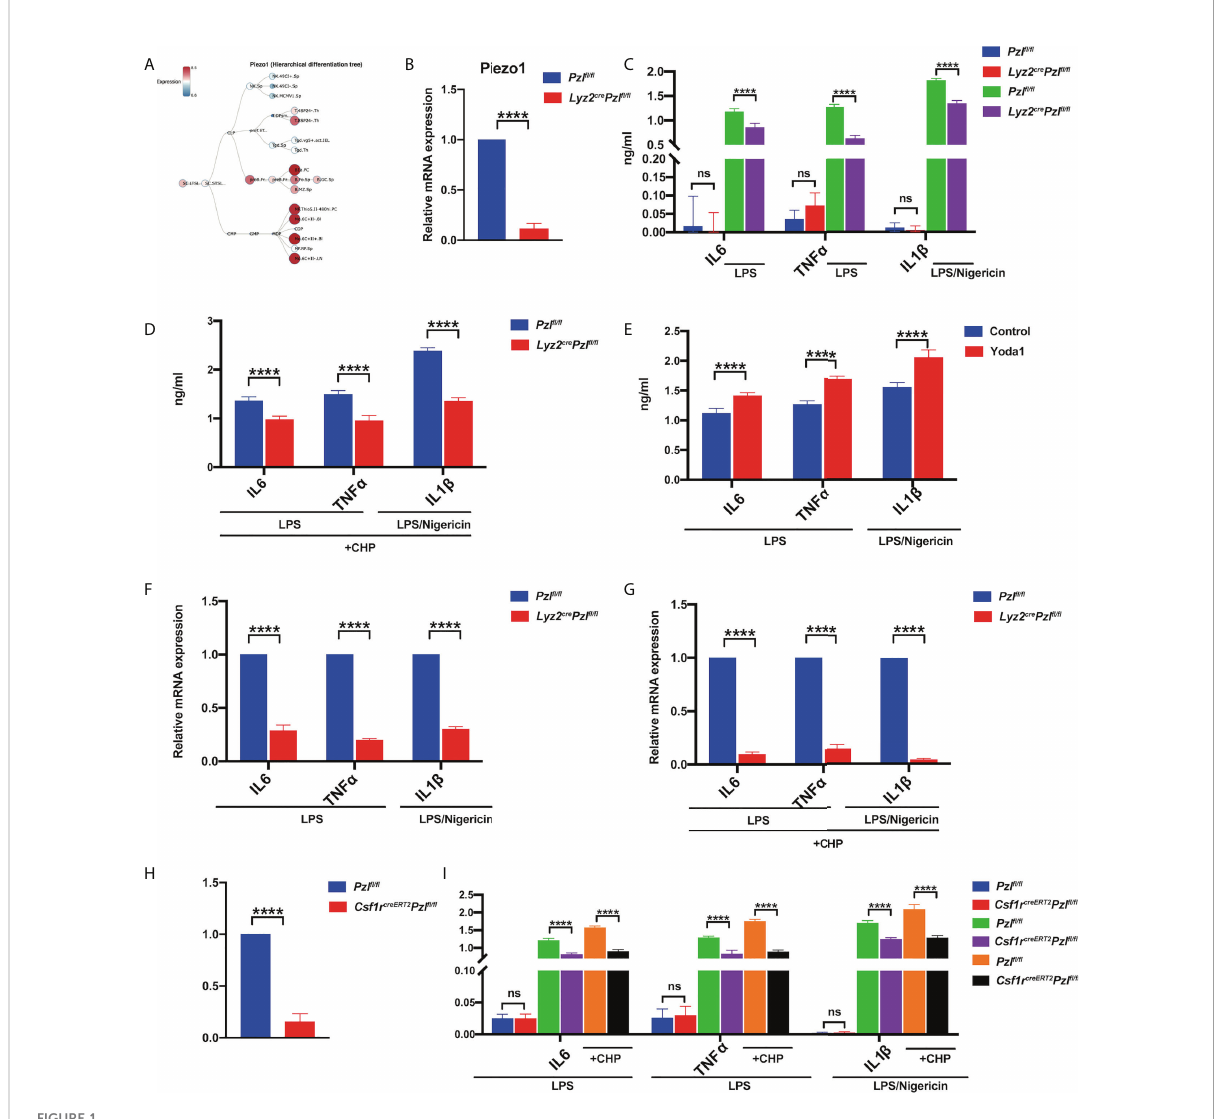
FIGURE 1 Piezo1 activation promotes LPS-induced expression and secretion of in fl ammatory cytokines. (A) A hierarchical differentiation tree depicting the expression of Piezo1 using BloodSpot (online software). (B) The expression of Piezo1 mRNA in the BMDMs from Lyz2 cre/+ Piezo1 fl ox/ fl ox and Piezo1 fl ox/ fl ox control mice relative to b -actin (n = 6). (C) IL6 and TNF- a levels in the BMDMs from Lyz2 cre/+ Piezo1 fl ox/ fl ox mice and Piezo1 fl ox/ fl ox control mice treated with 10 ng/ml LPS for 24 h; IL-1 b level in the BMDMs from Lyz2 cre/+ Piezo1 fl ox/ fl ox mice and Piezo1 fl ox/ fl ox control mice treated with 1 µg/ml LPS for 4 h and 25 µM nigericin for 30 min, measured by ELISA (n = 6). (D) IL6 and TNF- a levels in the BMDMs from Lyz2 cre/+ Piezo1 fl ox/ fl ox mice and Piezo1 fl ox/ fl ox control mice treated with 10 ng/ml LPS under cyclical hydrostatic pressure cycling once per second from 45 mmHg to 60 mmHg with 5% CO 2 at 37°C for 6 h; IL-1 b level in the BMDMs from Lyz2 cre/+ Piezo1 fl ox/ fl ox mice and Piezo1 fl ox/ fl ox control mice treated with 1 µg/ml LPS for 4 h and 25 µM nigericin for 30 min, measured by ELISA under CHP (n = 6). (E) IL6 and TNF- a levels in the BMDMs with 10 ng/ml LPS for 24 h pretreated with 10 µM Yoda1 or DMSO for 30 min; IL-1 b level in the BMDMs with 1 µg/ml LPS for 4 h and 25 µM nigericin for 30 min pretreated with 10 µM Yoda1 or DMSO for 30 min (n = 6). (F) Relative gene expression of IL6, TNF- a , and IL-1 b in the BMDMs from Lyz2 cre/+ Piezo1 fl ox/ fl ox mice and Piezo1 fl ox/ fl ox control mice incubated with 10 ng/ml LPS for 2 h or 1 ug/ml LPS for 4 h and 25 µM nigericin for 30 min (n = 6). (G) Relative gene expression of IL6 and TNF- a in the BMDMs from Lyz2 cre/+ Piezo1 fl ox/ fl ox mice and Piezo1 fl ox/ fl ox control mice treated with 10 ng/ml LPS for 2 h under cyclical hydrostatic pressure; relative gene expression of IL-1 b in the BMDMs treated with 1 ug/ml LPS for 4 h and 25 µM nigericin for 30 min (n = 6). (H) The expression of Piezo1 mRNA in BMDMs from Csf1r creERT2 ; Piezo1 fl ox/ fl ox and Piezo1 fl ox/ fl ox control mice relative to b -actin (n = 6). (I) IL6, TNF- a , and IL-1 b secretion in the BMDMs from Csf1r creERT2 ; Piezo1 fl ox/ fl ox mice and Piezo1 fl ox/ fl ox control mice incubated with 10 ng/ml LPS for 24 h, 1 µg/ml LPS for 4 h, and 25 µM nigericin for 30 min under static pressure or cyclical hydrostatic pressure (n = 6). Statistical signi fi cances were calculated using (C, I) one-way ANOVA, Tukey ’ s multiple comparisons test; (B, D – H) two-tailed Student t test. Data are expressed as the mean ± SD. **** P < 0.0001, ns, not signi fi cant. BMDMs, bone marrow-derived macrophages; Lyz2 cre/+ Piezo1 fl ox/ fl ox , conditionally Piezo1-de fi cient mice; IL, interleukin; TNF- a , tumor necrosis factor a ; LPS, liposaccharide; CHP, cyclical hydrostatic